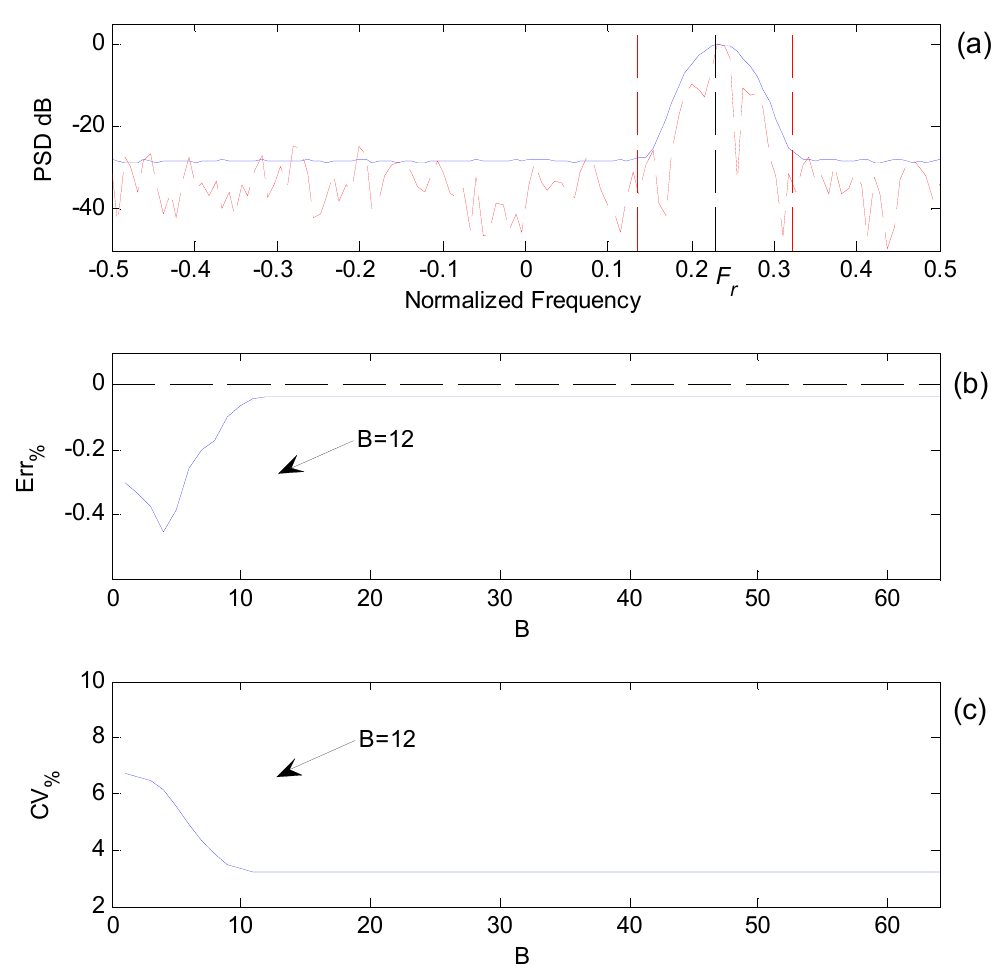
Figure 3. Performance of the proposed estimator at different values of B. ( a ) Mean Doppler spectrum (blue curve) and a single spectrum (red dashed curve) produced by a flow signal with a nominal normalized Doppler frequency F r . ( b ) Accuracy achieved for B in the range 0–63. ( c ) Precision achieved for B in the range 0–63. Red dashed segments report the position for B = 12.